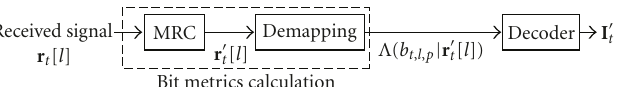
Figure 2: Decoding the signal of the source S t at the relay.